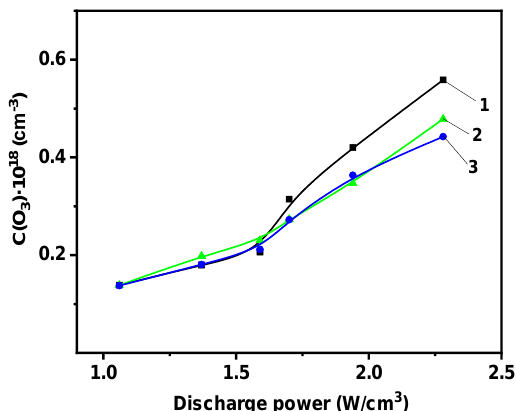
Figure 11. Change of ozone concentration in the liquid phase at the outlet of the reactor depending on the DBD discharge power (1—DBD + distilled water (blank sample); 2—DBD + RhB solution and 3—DBD + RhB solution in the presence of the TiO 2 -PAMMH photocatalyst).